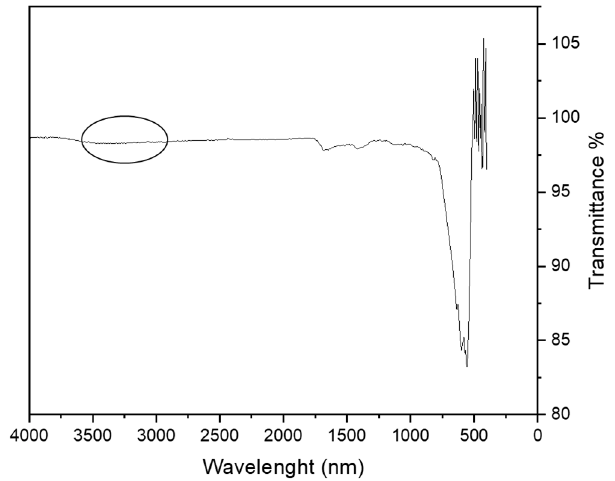
Figure 8. FTIR spectrum of the MA with 10% of coating after the adsorption of copper